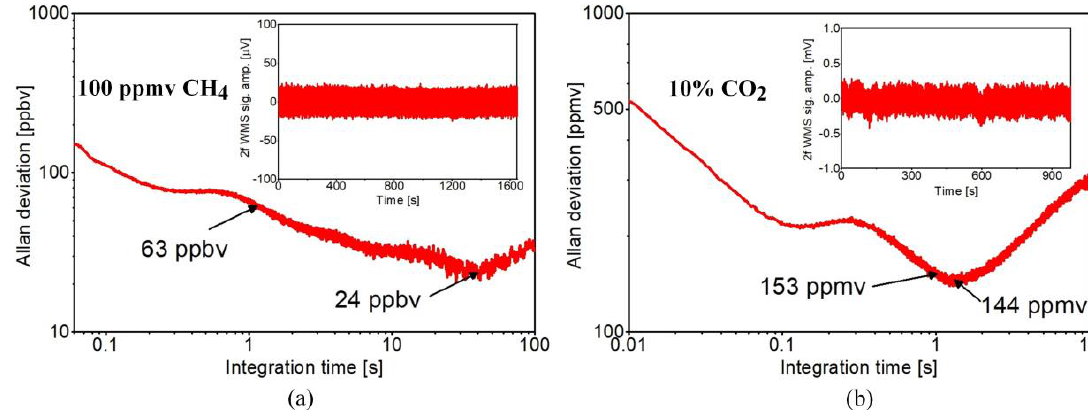
Figure 8. Allan – Werle plots estimating the performance of the sensor in detecting CH 4 -( a ) and CO 2 - ( b ). The plots were calculated based on 2f signal registered for pure N 2 flushed into the fiber and both excitation lasers tuned to the center of the gas transitions (insets in both graphs). The wavelength of the lasers was not actively